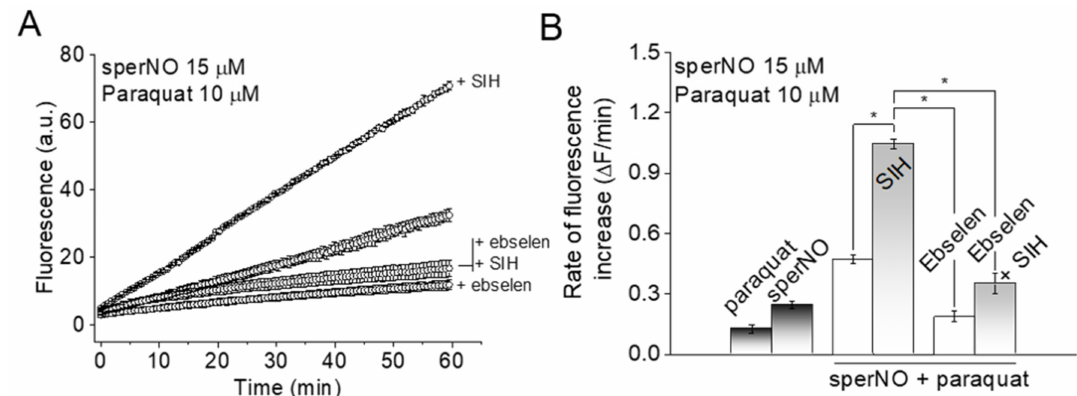
Figure 4. Sequestration of the LIP by chelation increases the peroxynitrite-dependent intracellular oxidation of H 2 DCF. ( A ) Fluorescence traces of the formation of DCF in cells treated with PQ/NO • in the presence and absence of Ebselen and SIH; Briefly, H 2 DCF-loaded RAW 264.7 cells were transferred to 96-well plates (1.2 × 10 7 cells/mL). Paraquat (10 µ M), SIH (100 µ M), and Ebselen (50 µ M) were individually added to selected wells in this order. The fluorescence measurements were initiated immediately after sperNO (15 µ M) was introduced and registered every minute for one hour. Each trace represents the mean ± standard deviation (S.D.) of four experiments. ( B ) The rate at which the fluorescence of DCF increased. This parameter was determined by linear regression of the fluorescence data presented in panel A, by using the data collected during the first 10 min of each run. The data represent the mean of four independent experiments ± S.D. and are statistically significant at the 95% confidence interval relative to control cells * ( p < 0.05, Paired Student’s t -test). The assays were performed in PBS and DTPA (100 µ M), at pH 7.4, and 37 ◦ C. The conditions and fluorescence acquisition and parameter settings were the same as those described in Figure